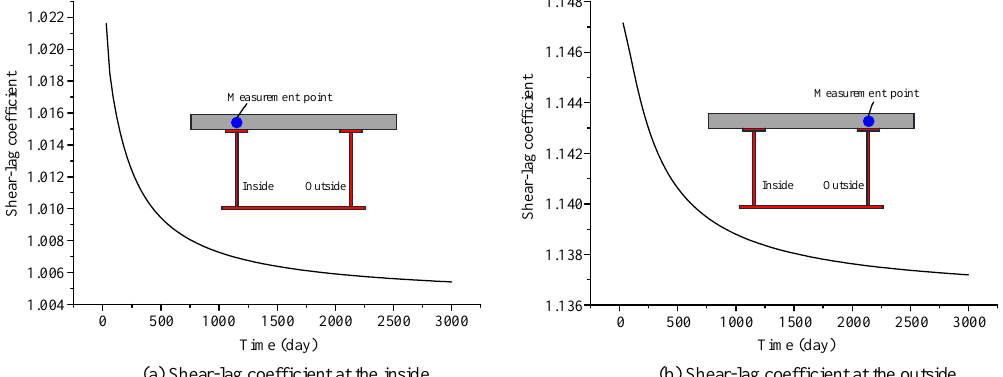
Figure 7. Change in the shear-lag warping strength function of the concrete slab, with respect to time: ( a ) shear-lag coefficient at the inside; ( b ) shear-lag coefficient at the outside.